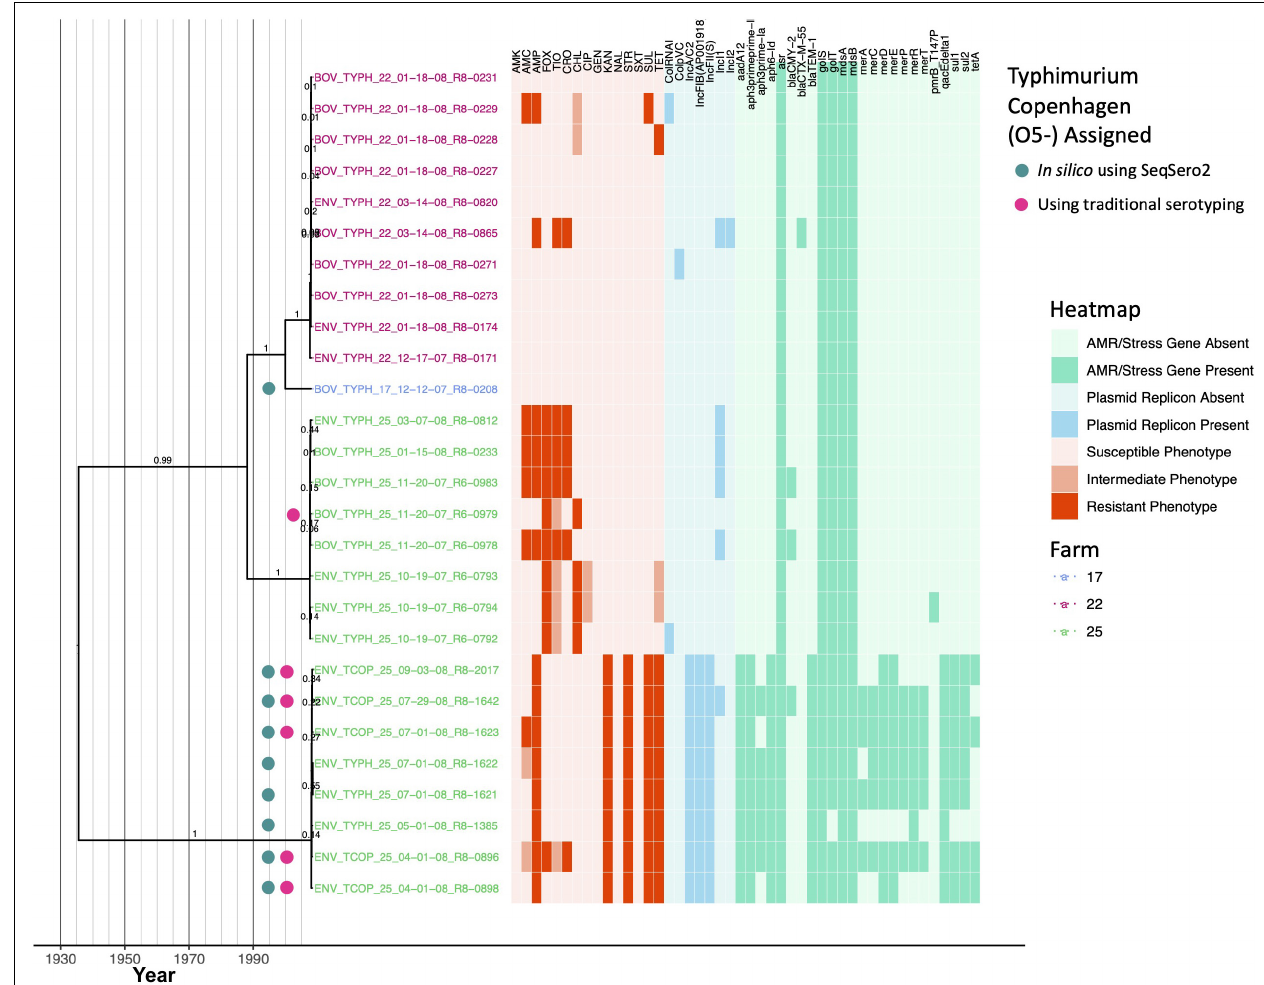
FIGURE 10 | Rooted, time-scaled maximum clade credibility (MCC) phylogeny constructed using core SNPs identified among 27 Salmonella Typhimurium and Typhimurium Copenhagen genomes isolated from subclinical bovine sources and the surrounding bovine farm environment. Tip label colors denote the ID of the farm from which each strain was isolated. Circles to the left of tip labels denote isolates that were assigned to the Typhimurium Copenhagen variant of S. Typhimurium using SeqSero2 (teal) and/or traditional serotyping (pink). Branch labels denote posterior probabilities of branch support. Time in years is plotted along the X -axis, and branch lengths are reported in years. The heatmap to the right of the phylogeny denotes (i) the susceptible-intermediate-resistant (SIR) classification of each isolate for each of 15 antimicrobials (obtained using phenotypic testing and NARMS breakpoints; orange); (ii) presence and absence of plasmid replicons (detected using ABRicate/PlasmidFinder and minimum nucleotide identity and coverage thresholds of 80 and 60%, respectively; blue); (iii) presence and absence of antimicrobial resistance (AMR) and stress response genes (identified using AMRFinderPlus and default parameters; green). Core SNPs were identified using Snippy. The phylogeny was constructed using the results of ten independent runs using a relaxed lognormal clock model, the Standard_TPM1 nucleotide substitution model, and the Coalescent Bayesian Skyline population model implemented in BEAST version 2.5.1, with 10% burn-in applied to each run. LogCombiner-2 was used to combine BEAST 2 log files, and TreeAnnotator-2 was used to construct the phylogeny using common ancestor node heights. Abbreviations for the 15 antimicrobials are: AMK, amikacin; AMC, amoxicillin-clavulanic acid; AMP, ampicillin; FOX, cefoxitin; TIO, ceftiofur; CRO, ceftriaxone; CHL, chloramphenicol; CIP, ciprofloxacin; GEN, gentamicin; KAN, kanamycin; NAL, nalidixic acid; STR, streptomycin; SXT, sulfamethoxazole-trimethoprim; SUL, sulfisoxazole; TET,